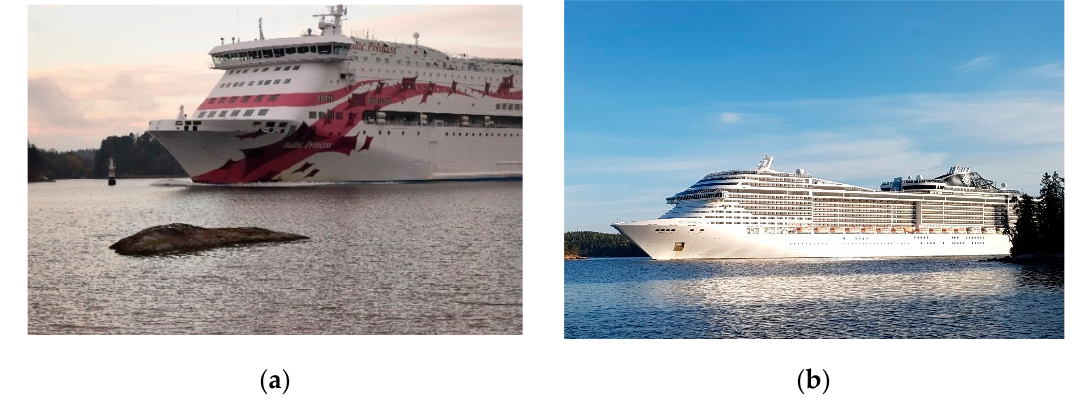
Figure 3. ( a ) Example of one of the larger passenger ferries, Baltic Princess, and ( b ) a large cruise ship, MSC Prezoria, sailing through the Furusund fairway.